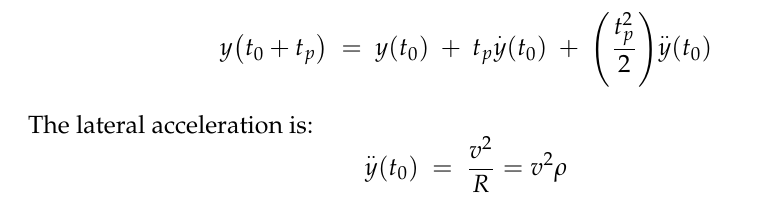
Figure 2. Optimal curvature model of relative vehicle–road position.